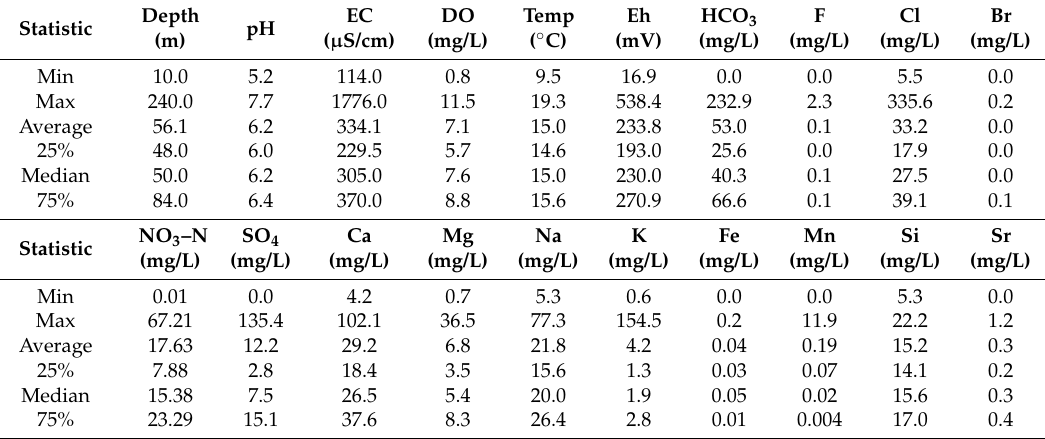
Table 1. Summary of statistics of measured field parameters and concentrations of dissolved